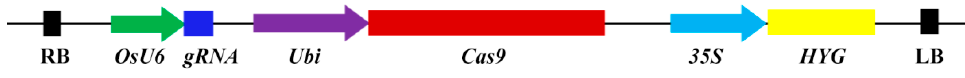
Figure 5. The vector construction